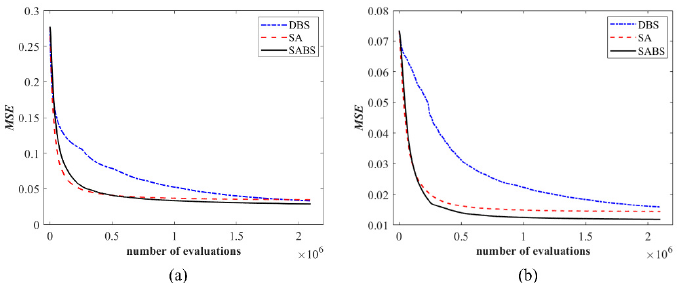
Figure 4. The comparison with DBS, SA, and SABS. ( a ) The MSE versus the number of evaluations for the off-axis scheme. ( b ) The MSE versus the number of evaluations for the off-axis scheme.